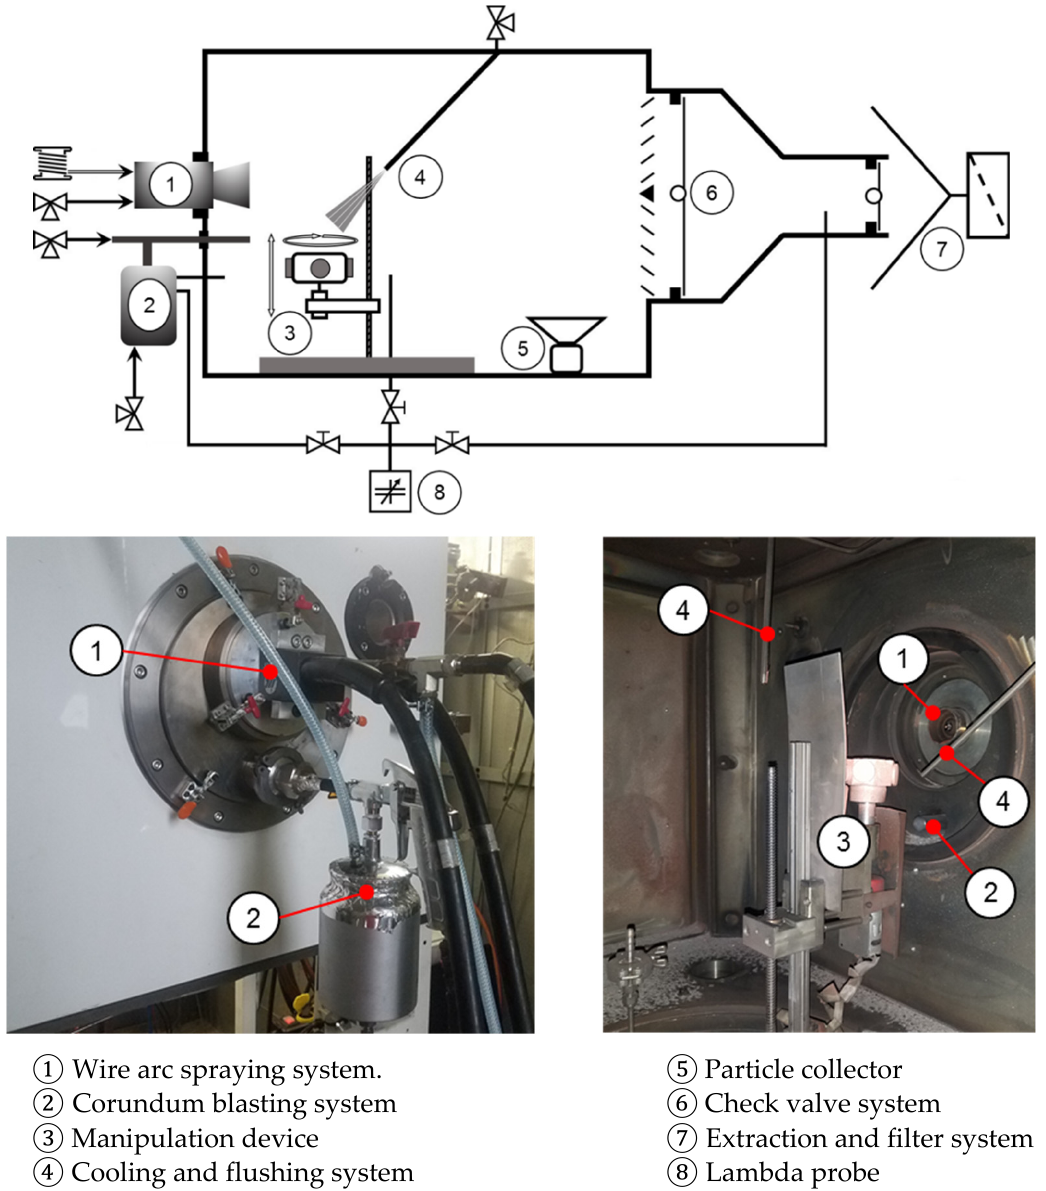
Figure 1. Custom-built process chamber with an attached blasting and twin wire arc coating system [21].